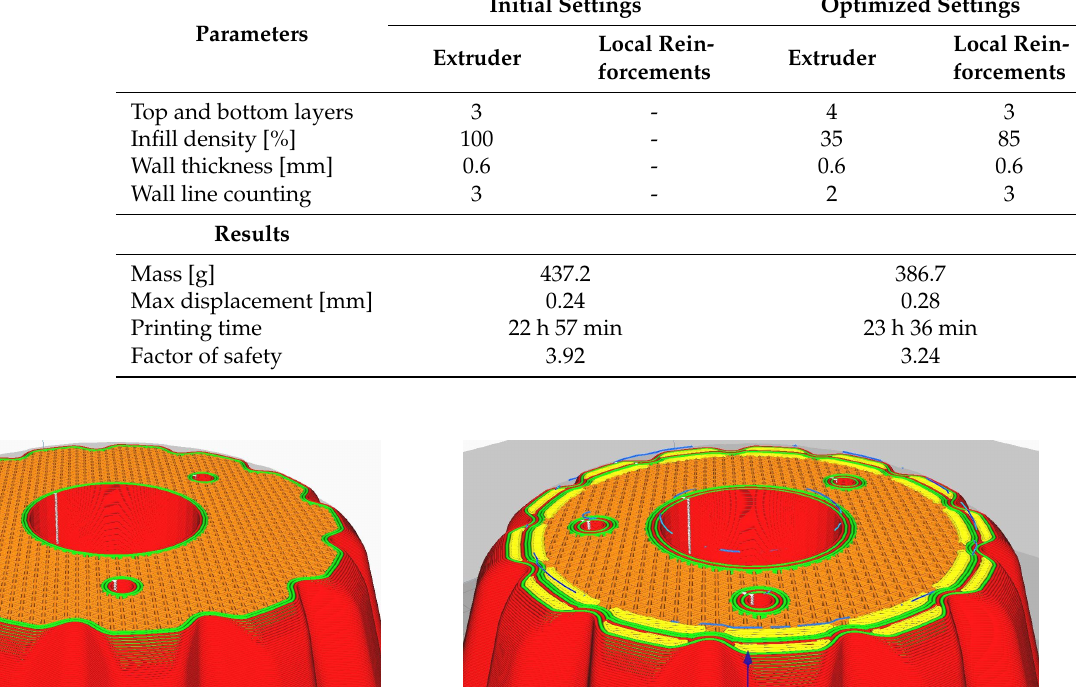
Figure 11. 3D printed geared friction wheel slicing comparison: initial ( left ) and optimized slicing ( right ) performed with the 3D printing software Cura slicer from Ultimaker; the red lines denote external shell surface, orange and yellow the infill regions, and green the inner